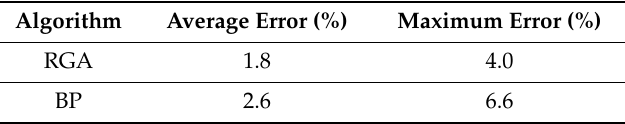
Table 1. The comparison between BP and RGA.